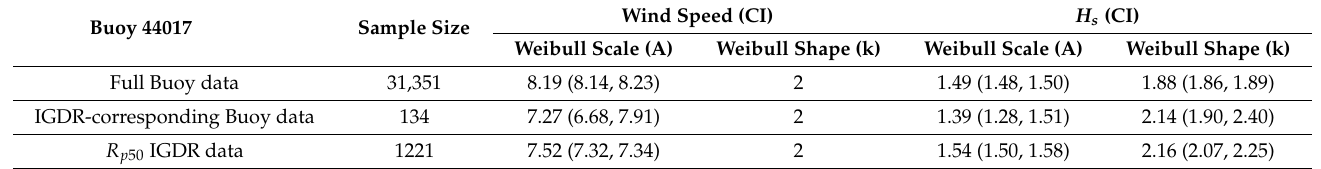
Table 5. Weibull shape and scale values with 95% confidence interval in parentheses for satellite and buoy data around Buoy